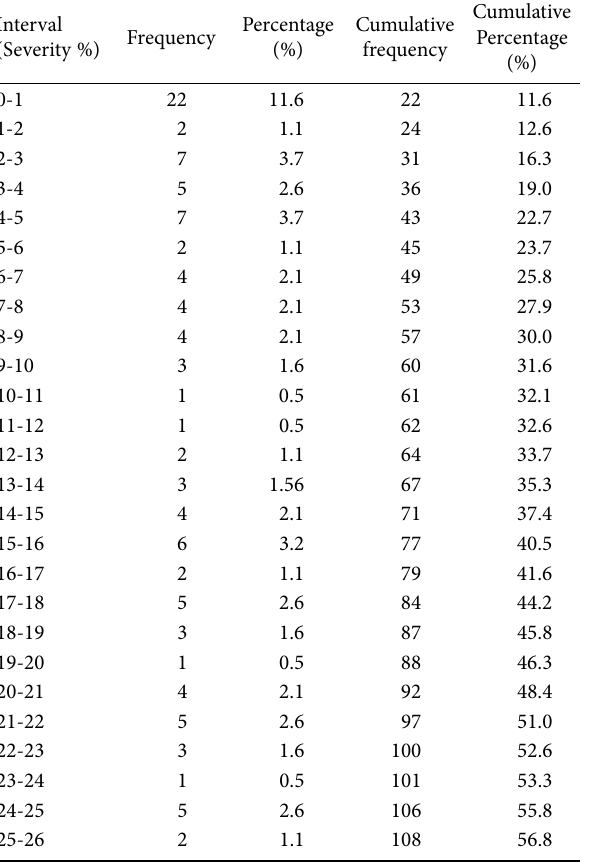
Table 1. Frequency distribution, in unit intervals, of disease severity values (%) of rust on fig leaves. Interval (Severity %)